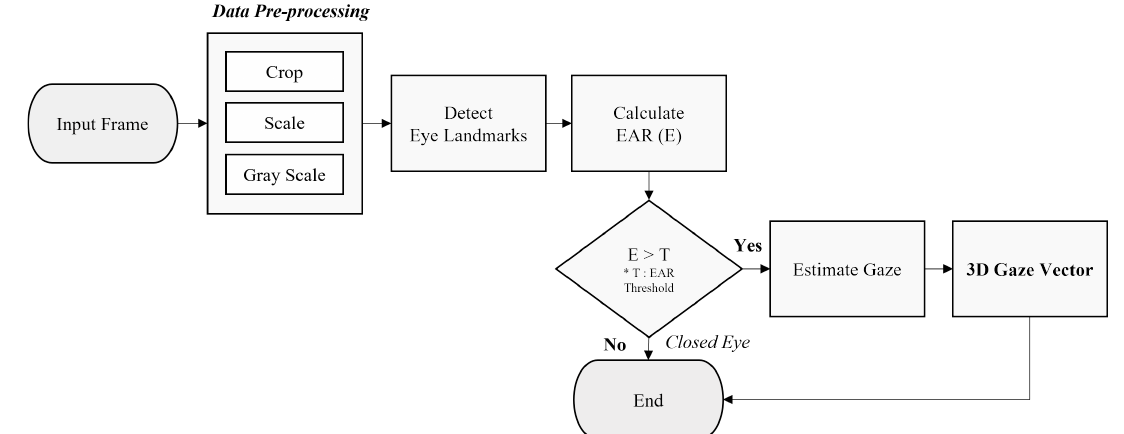
Figure 2. Overall flowchart of our feature-based gaze-estimation